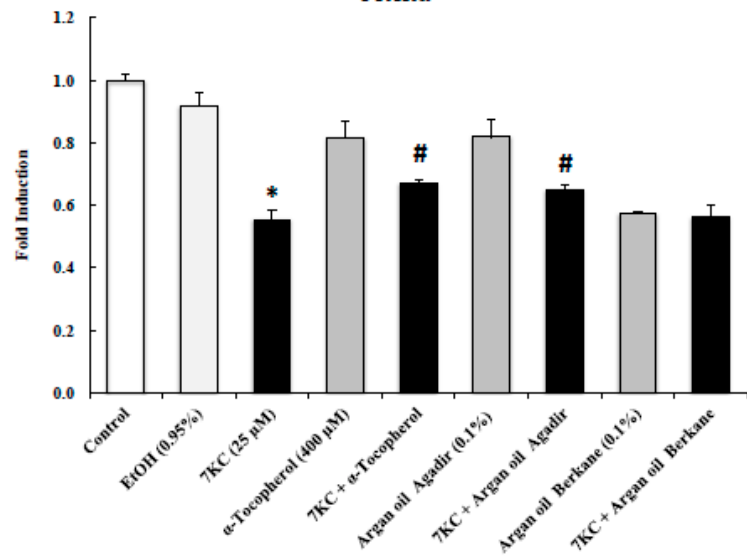
Figure 6. Effects of argan oil on 7-ketocholesterol-induced decreased transcription of PPAR α . After 24 h of culture, 158N murine oligodendrocytes were cultured for an additional 24 h without or with 7KC (25 µM) in the absence or presence of argan oils (Agadir or Berkane; Morocco; 0.1% v / v ) or of α -tocopherol (400 µM) used as the positive control. Argan oils and α -tocopherol were added to